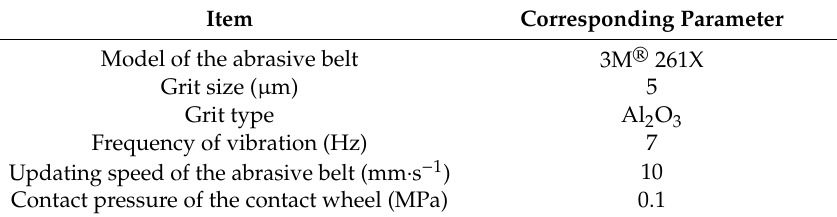
Table 3. Parameters of figuring process.